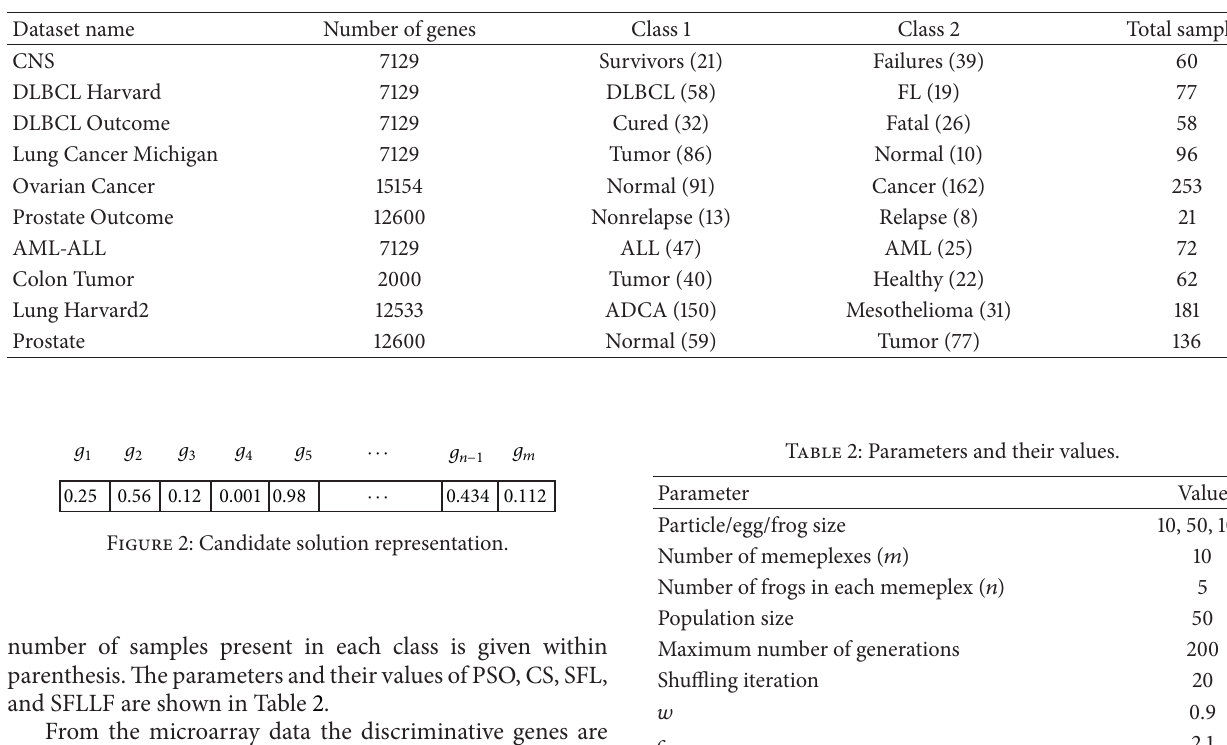
Table 1: Microarray gene expression datasets.